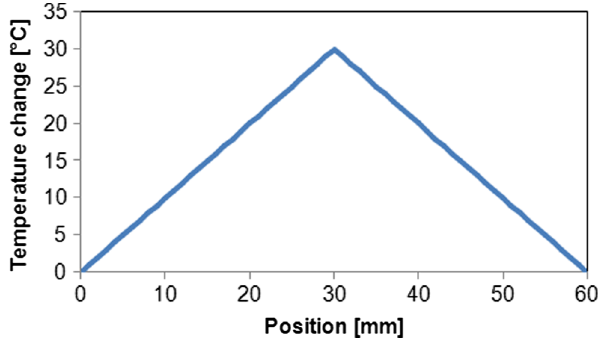
FIG. 5. Triangular distribution of the target wire temperature change in LA-VWM.